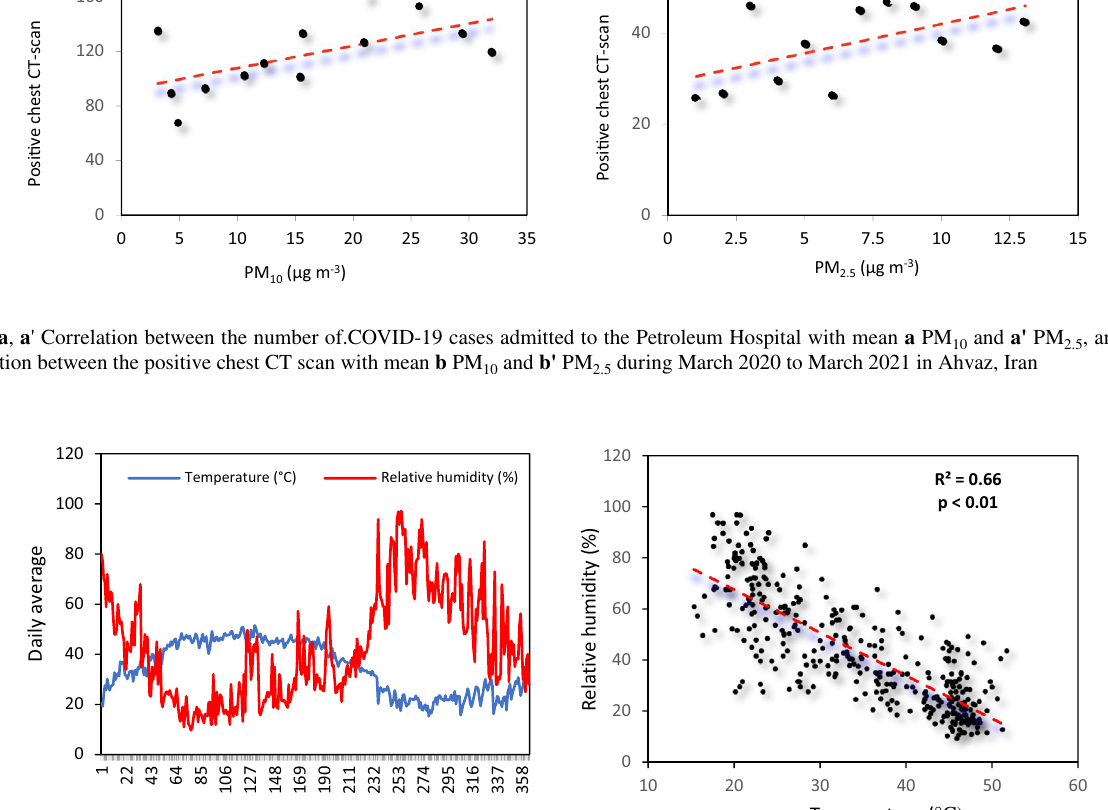
Fig. 4 Trend daily variations of a air temperature and relative humidity and a' correlation between daily temperature and relative humidity